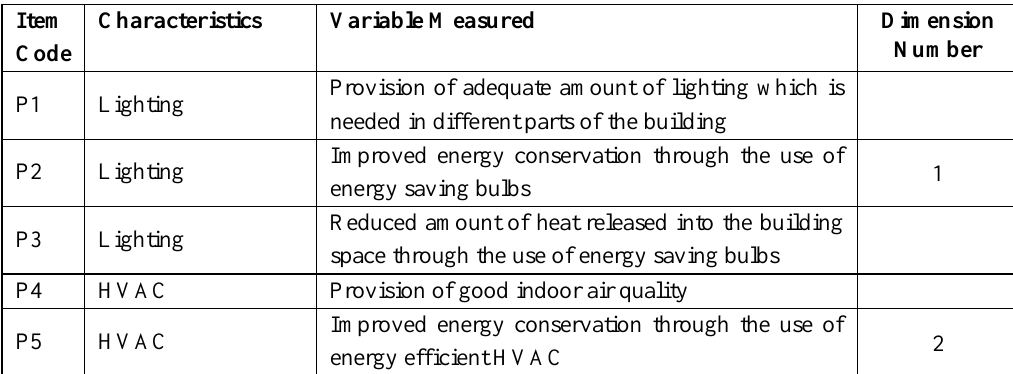
Table 1. Dimensioning of Building Commissioning Practices (developed by the